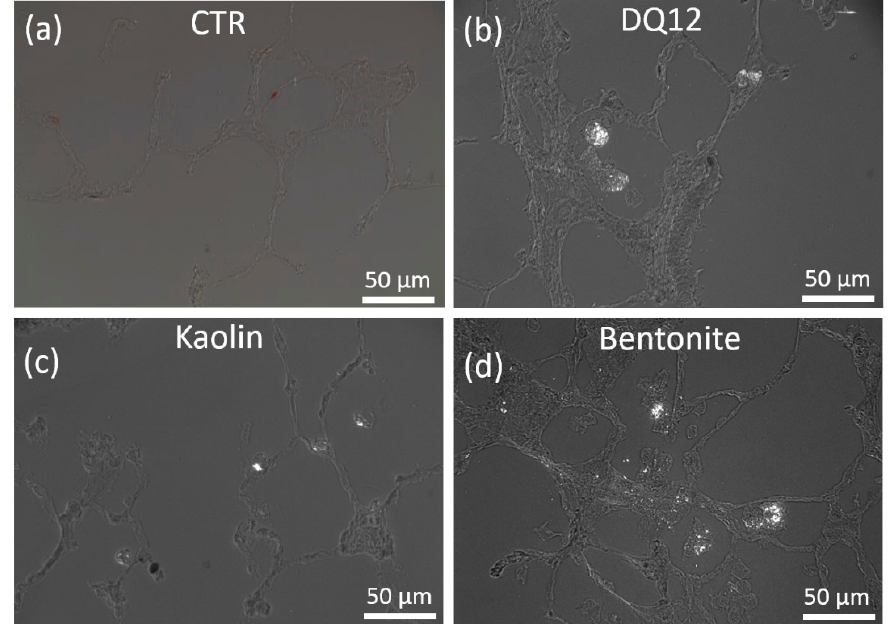
Figure 5. Detection of polarizing particles in quartz DQ12, kaolin, and bentonite-laden rat lungs. Cryo-sections investigated by polarization microscopy (polarizers 90 ◦ crossed). Animals were intratracheally instilled with vehicle ( a , CTR), or 1.2 mg of either quartz DQ12 ( b ), kaolin ( c ), or bentonite ( d ), and were sacrificed after 21 days. Bright particulate matter occurred in discrete macrophage-like cells facing the alveolar lumen. In bentonite-treated lungs ( d ), particles were less concentrated and occurred with alveolar septa.